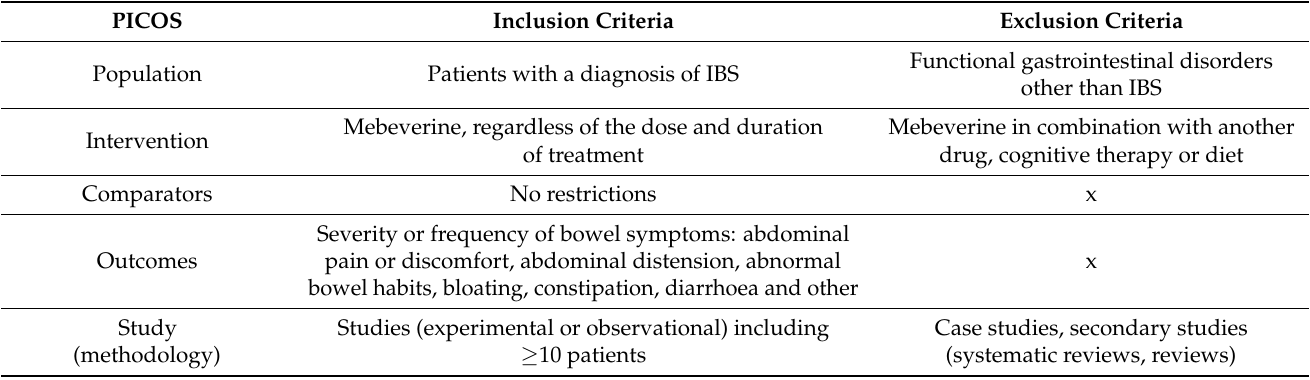
Table 1. Inclusion and exclusion criteria for systematic literature